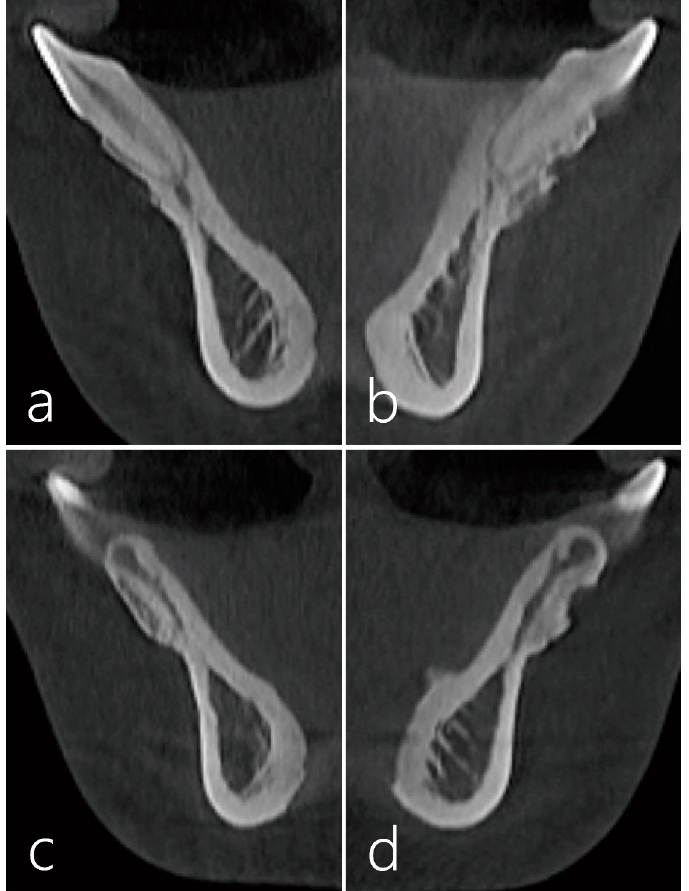
Figure 4. ( a , b ) The cross-sectional CBCT scans 5 years after the surgery showed well maintained labial bone plate at the midfacial side of both mandibular central incisors. ( c ) On the cross-sectional CBCT scan at the interdental site between the right lower central and lateral incisors, hard tissue phenotype modification was observed on the labial side. ( d ) On the cross-sectional CBCT scan at the interdental site between the left lower central and lateral incisors, partial depression was present but hard tissue phenotype was improved